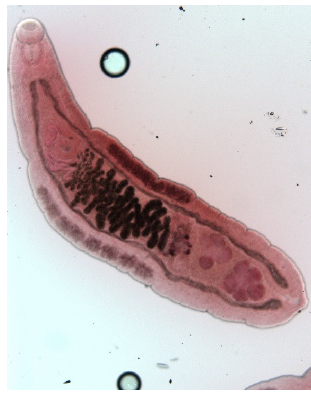
Figure 7. Opisthorchis felineus. Deeply lobed testes are situated at the posterior end. The uterus between ovary and ventral sucker does not overlap intestinal branches.